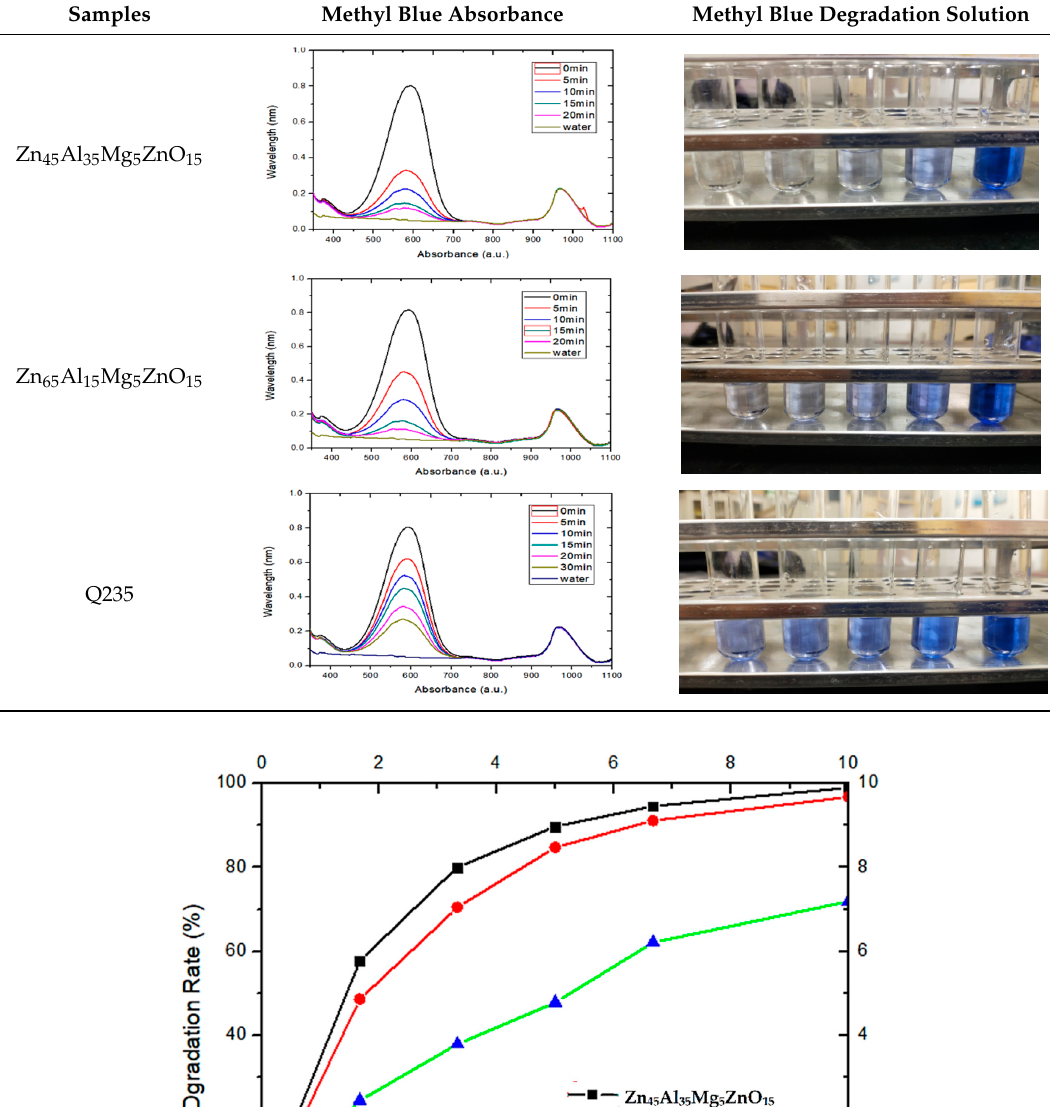
Table 2. Degradation of methyl blue solution by Zn 65 Al 15 Mg 5 ZnO 15 , Zn 45 Al 35 Mg 5 ZnO 15 , and matrix steel Q235 under ultraviolet light.